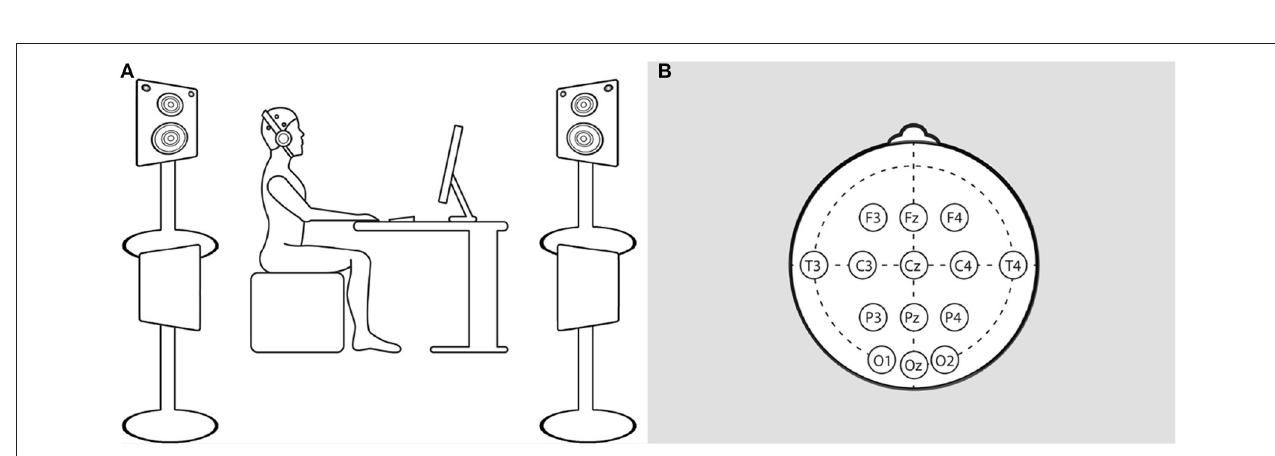
FIGURE 1 | (A) Schematic presentation of the whole test setup, including measurements, stimulus presentation, and the acoustical setup. Four loudspeakers were mounted on stands at the height of 1.0 m, placed at a 1.5 m distance to the participant and in at a 90 ◦ angle to each other. (B) Illustration of the environmental noise situation in the noise and noise-canceling condition. It consisted of a combination of frequent numbers, environmental noise, and speech snippets.